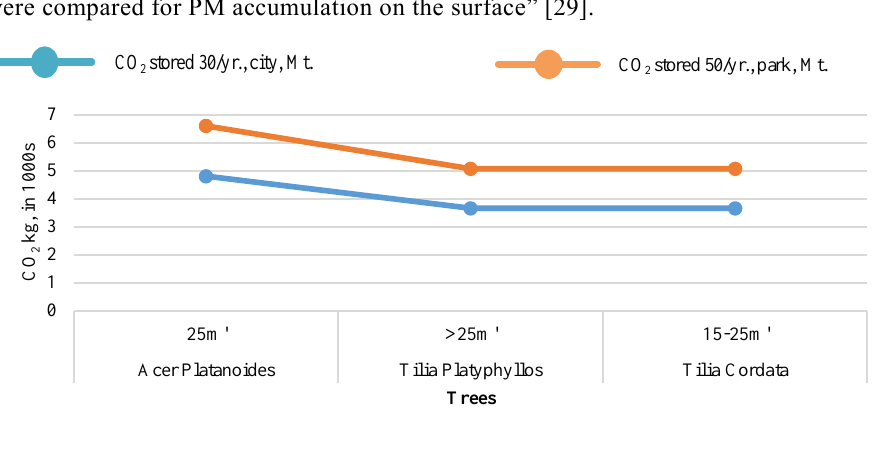
Fig. 4. Trees that can reduce air